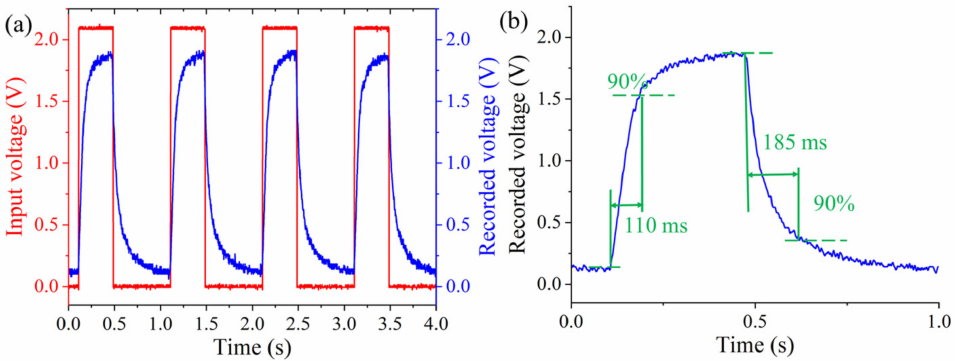
Figure 7. Dynamic response of the proposed varifocal scanning device. ( a ) The recorded voltage of the photodetector when the input voltage was a square signal, with a frequency of 1 Hz and an amplitude of 2.0 V. ( b ) The measured rise time and fall time of the proposed varifocal scanning device. The rise and fall times were 110 ms and 185 ms,